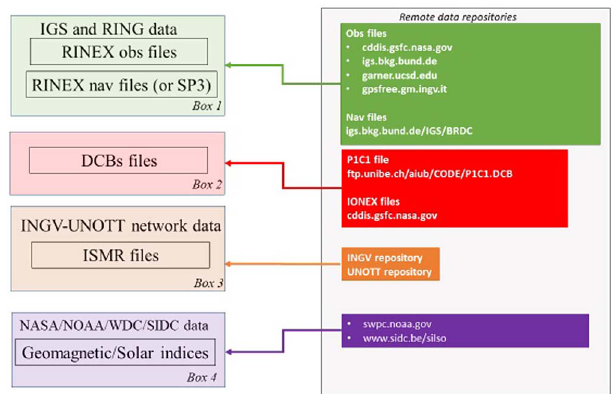
Fig. 3. Block diagram summarizing the data repositories necessary to run the RPF 2 algorithms. In addition to the world wide recognized repositories, note the RING geodetic network (http://ring.gm.ingv.it/), constituted by about 180 dual frequency receivers over Italy managed by Istituto Nazionale di Geo fi sica e Vulcanolgia (INGV, Italy) and the ISMRs (sampling at 50 Hz) operational at Northern Europe managed by INGV and University of Nottingham (UNOTT, United Kingdom) (Table